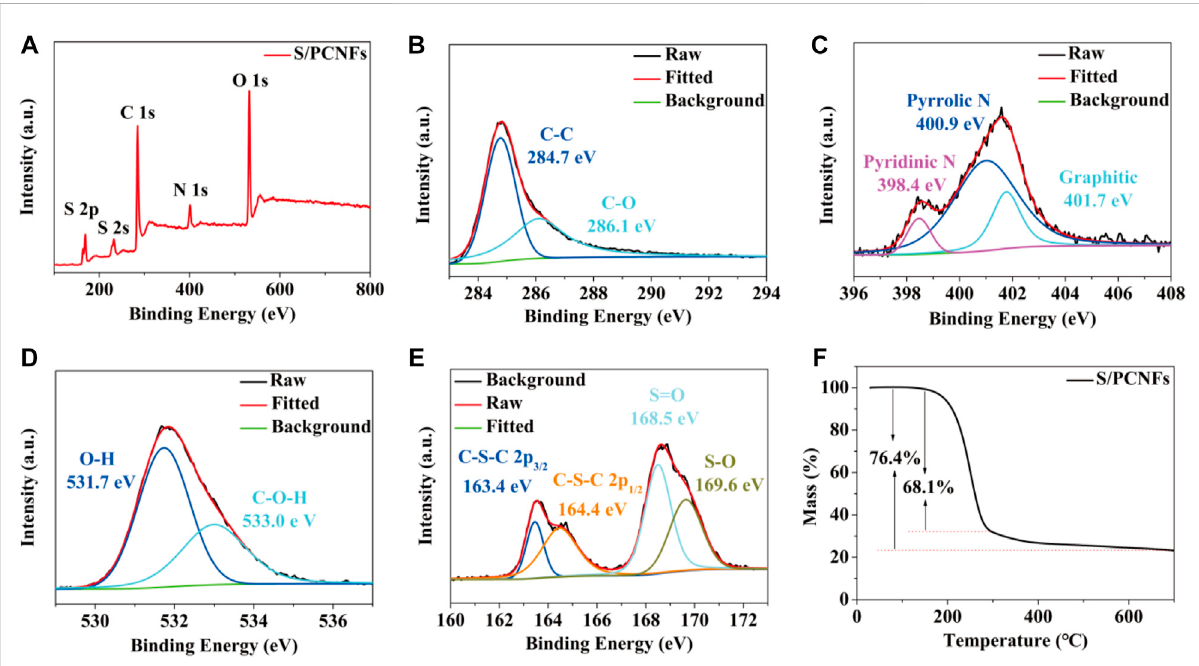
(Figure 2D). The element mapping of the HPCHFs@S cathode furthered uniform dispersion of C, N, O, and S (Figures 2E –